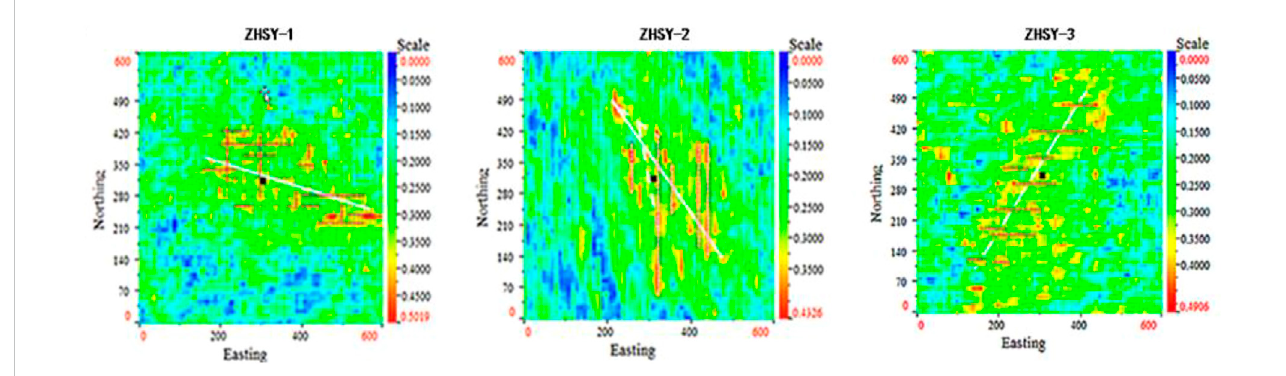
FIGURE 10 Comparison of fracture extension